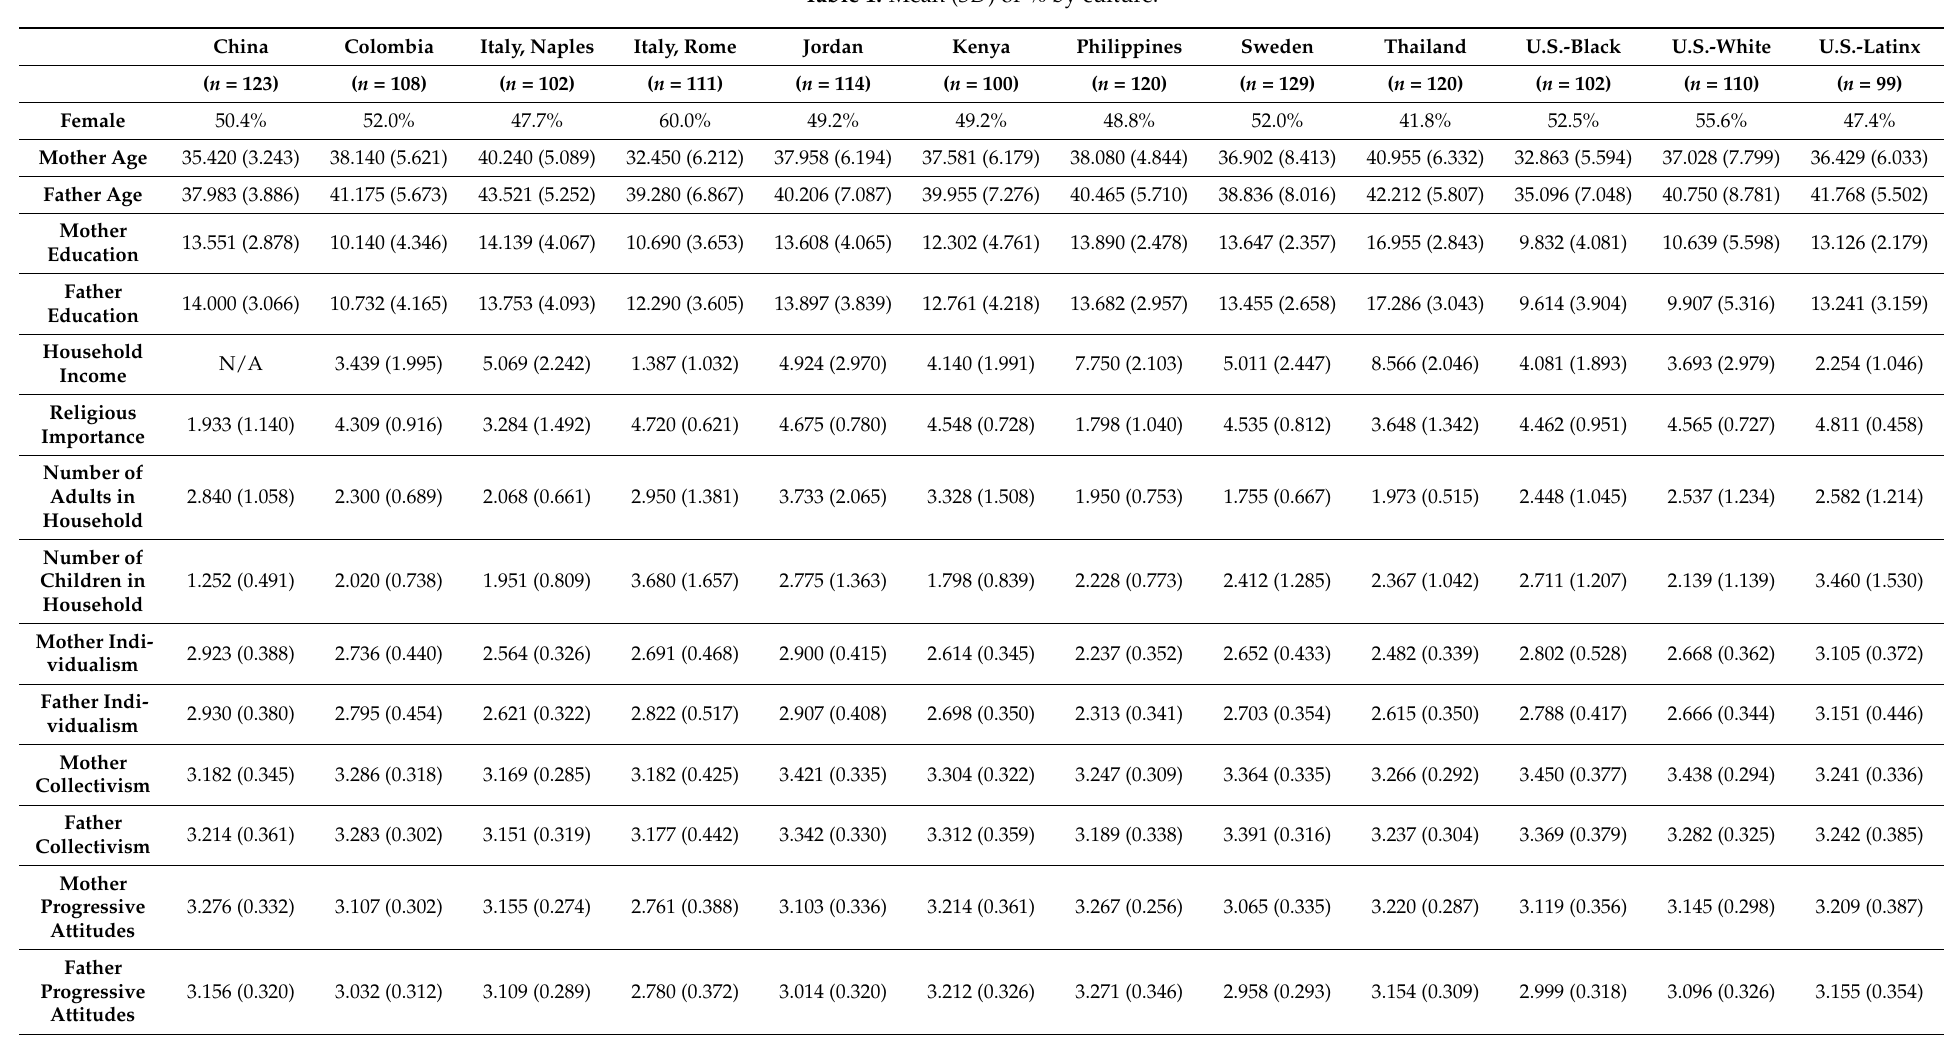
Table 1. Mean ( SD ) or % by